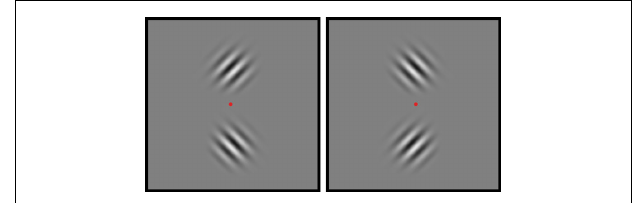
FIGURE 2 |Target stimuli for Experiment 3. Two gabor patches, one tilted 45˚ clockwise and the other tilted 45˚ counterclockwise, were located above and below the central fixation